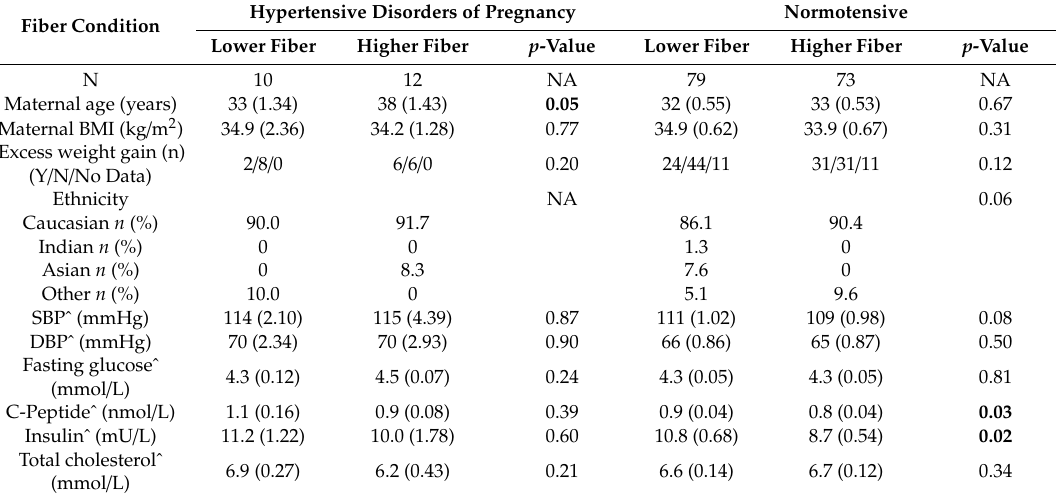
Table 1. Participant Characteristics Lower and Higher Fiber Groups at 28 weeks